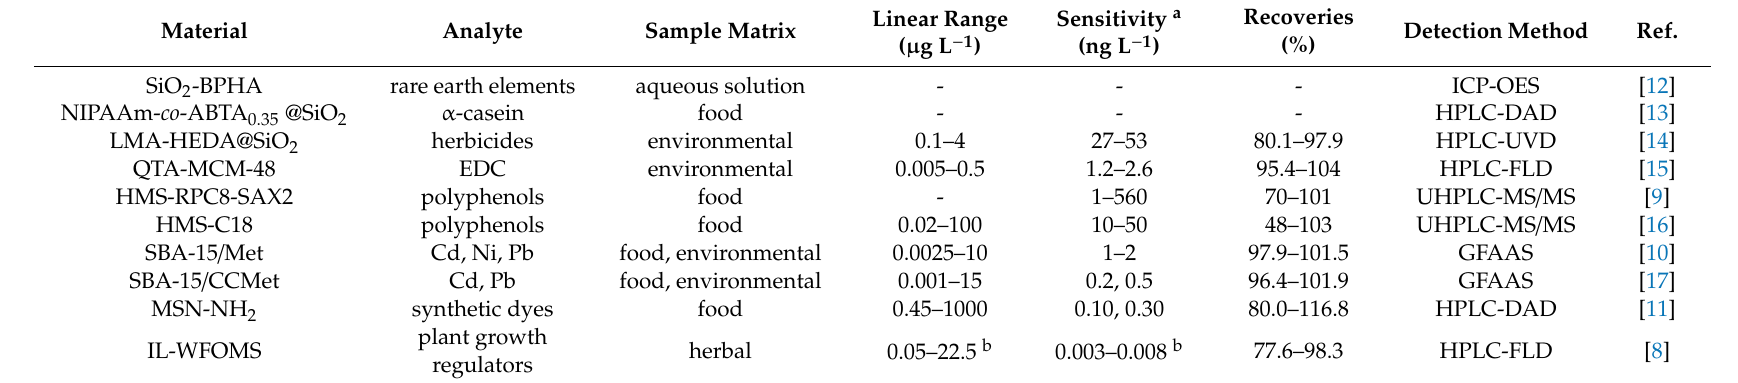
Table 1. Silica-based